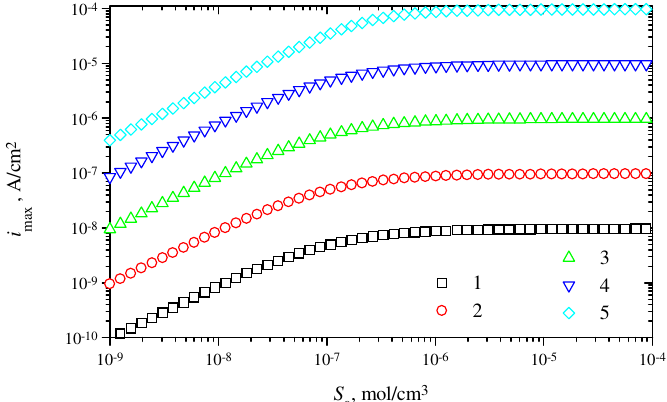
Figure 6 . The dependence of the maximal biosensor current i max on the substrate concentration S 0 at five maximal enzymatic rates V : 10 -10 (1), 10 -9 (2), 10 -8 (3), 10 -7 (4) and 10 -6 (5) mol/cm 3 s, d max =